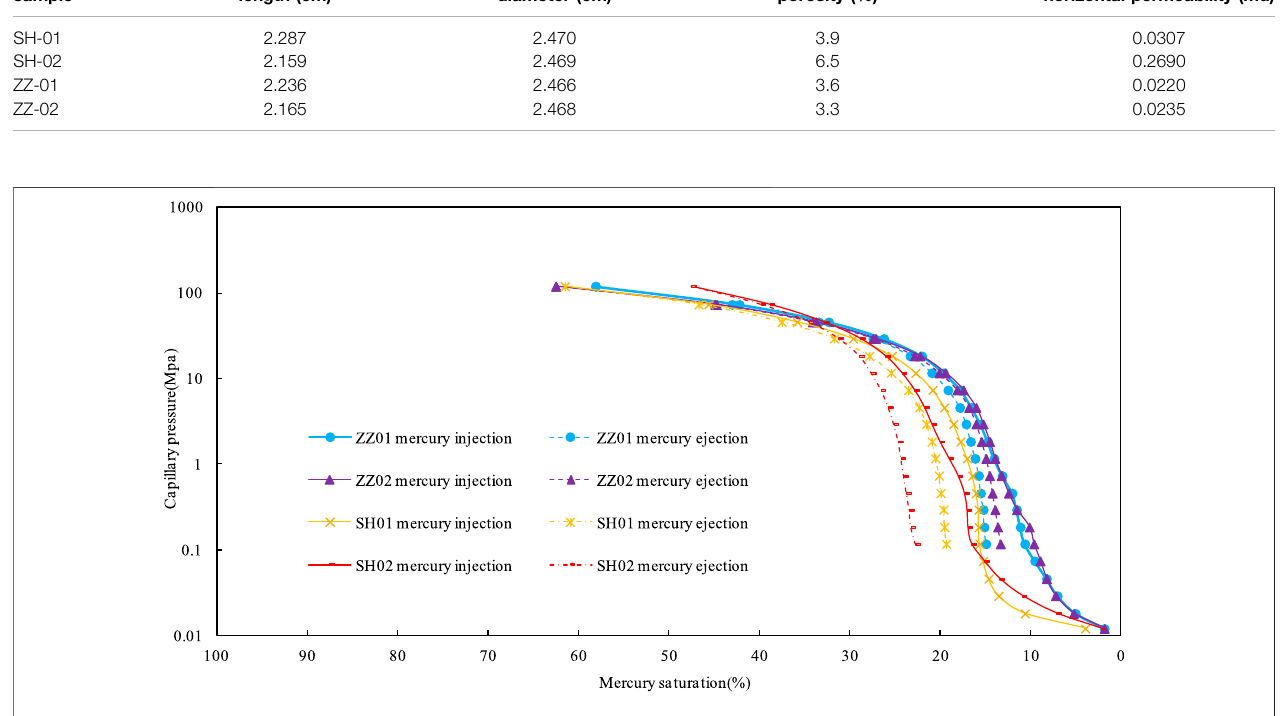
FIGURE 2 | Mercury saturation and capillary pressure curve of No. 3 coal